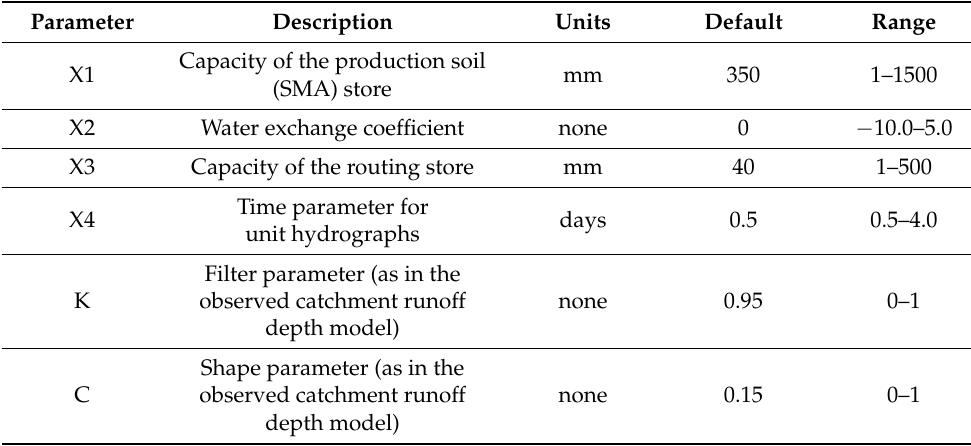
Table 1. Parameters in GR4J and their default values are adapted from [27].